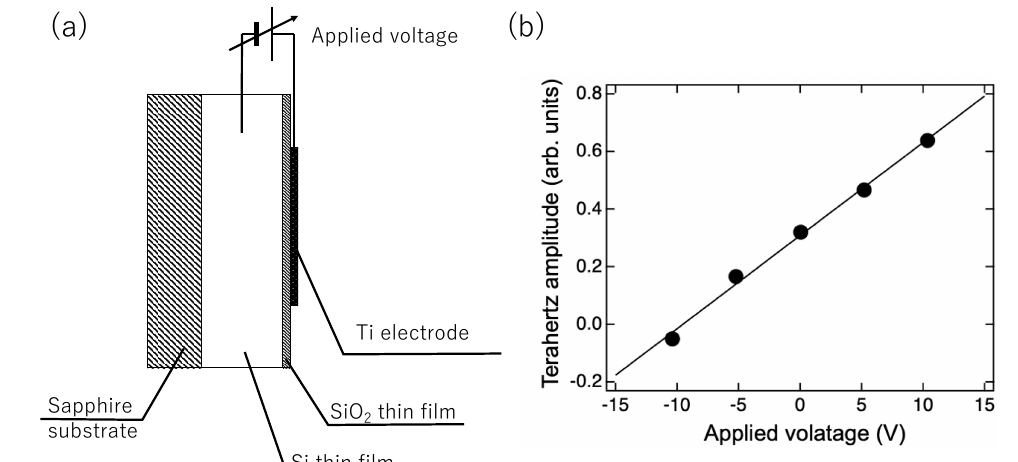
Figure 3. Relation between the electric potential on the sensing-plate surface and the amplitude of the radiated THz pulses. ( a ) Schematic of the Ti electrode on the sensing plate; ( b ) amplitude of the THz pulses as a function of the applied voltage. The black line is the best linear fit to the data.